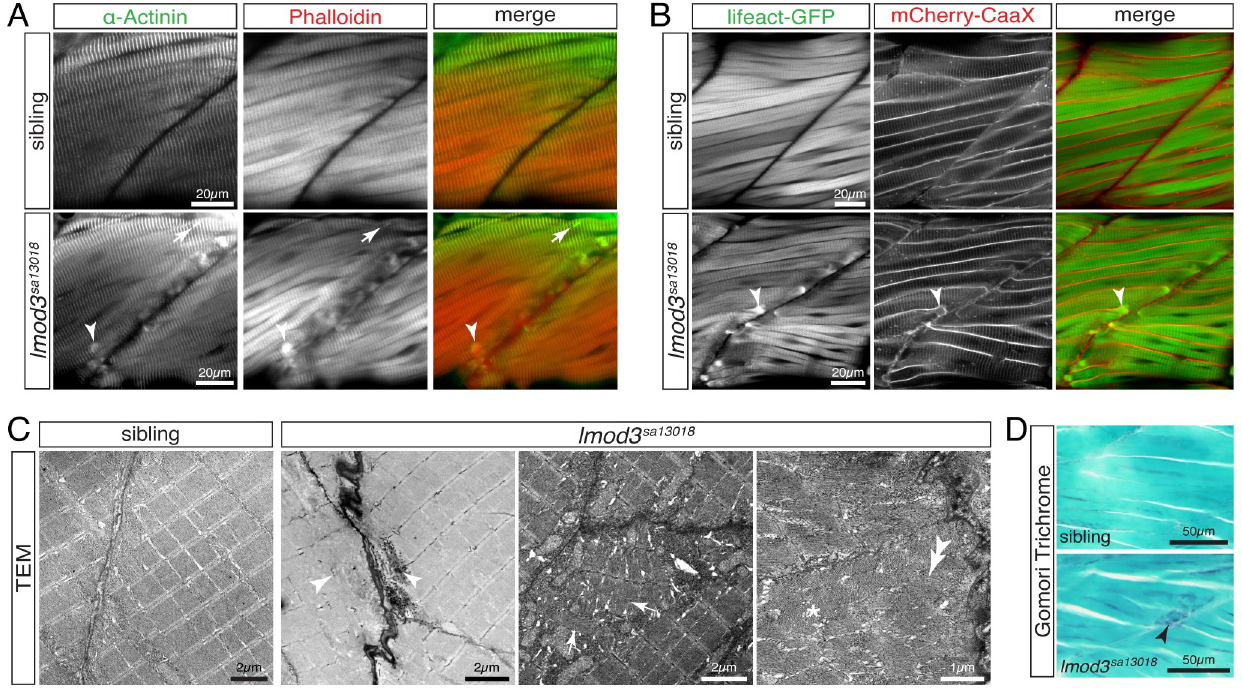
Fig 3. Aggregates within 4-dpf-old lmod3 sa13018 are reminiscent of nemaline bodies formed within nemaline myopathy patients. (A) Immunohistochemistry using antibodies against α -Actinin (green) and phalloidin staining (red) marked aggregates located close to vertical myosepta of 4-dpf-old lmod3 sa13018 homozygotes. Detected aggregates (arrowhead) were of various sizes and shapes, including rod-shaped structures (arrow). (B) Labelling of the myofibril with Lifeact-GFP (green) and the sarcolemma with mCherry-CaaX (red) confirmed aggregate (arrowhead) formation in lmod3 sa13018 homozygotes at 4 dpf, again exclusively at vertical myosepta. (C) At 4 dpf, transmission electron micrographs (TEM) of skeletal muscle from siblings showed the typical myofibril striation and well-aligned sarcomeres. Comparable sarcomeres were also present within lmod3 sa13018 homozygotes. However, close to the vertical myosepta, filament deposits reminiscent of fingerprint bodies (star), misaligned sarcomeres (arrows), and electron-dense aggregates of various sizes (arrowheads) were detected. (D) At 5 pdf, Gomori trichrome-stained sagittal sections depicted blue/purple structures close to the vertical myosepta within myofibres of lmod3 sa13018 homozygotes. Scale bar sizes are